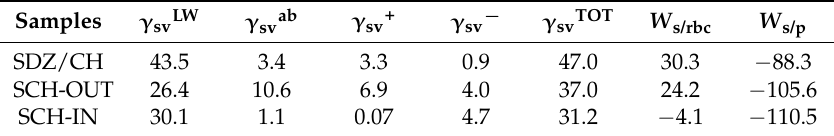
Table 4. Surface tension parameters and work of spreading (mN/m) for red blood cells and platelets of uniaxial and coaxial electrospun sulfadiazine-chitosan